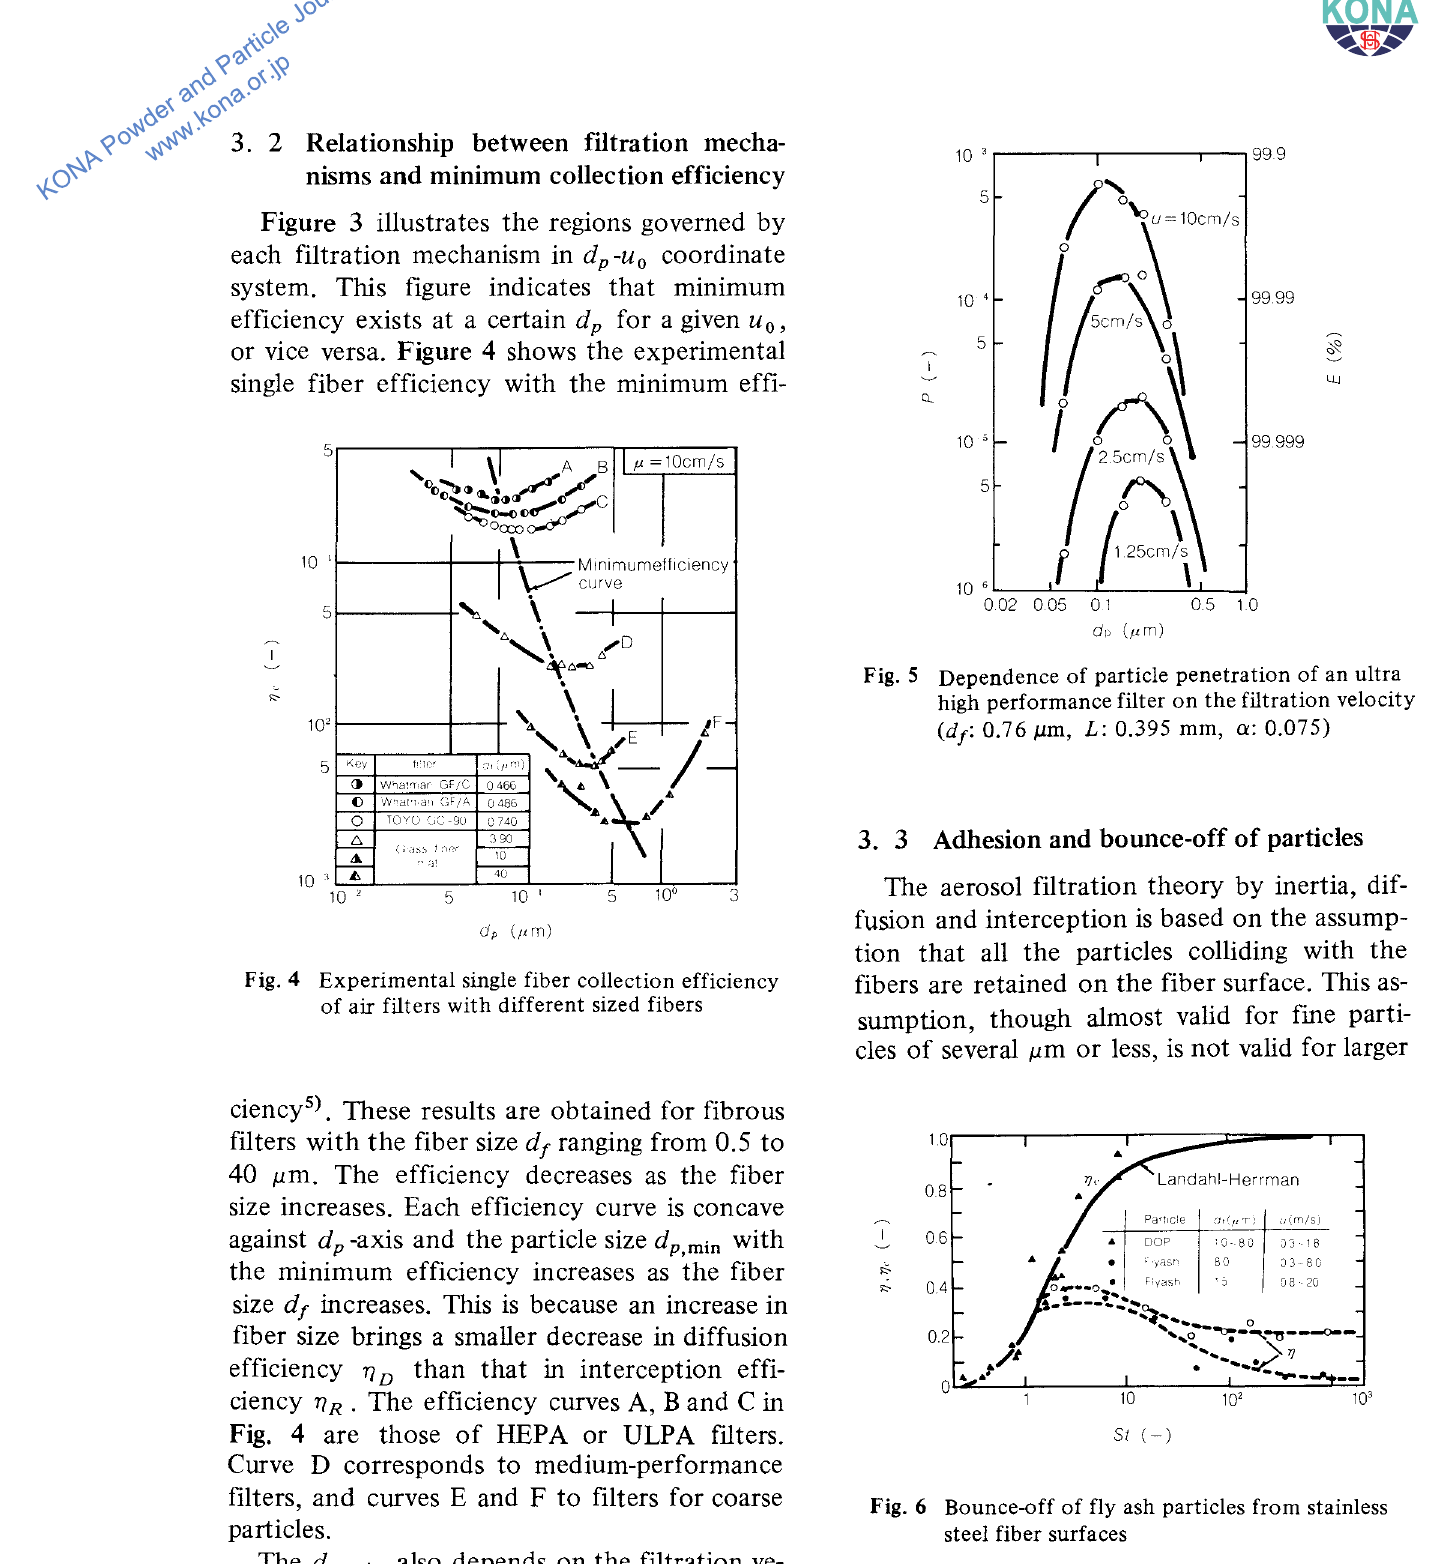
cle bounce-off on the fiber surface 6 >, where